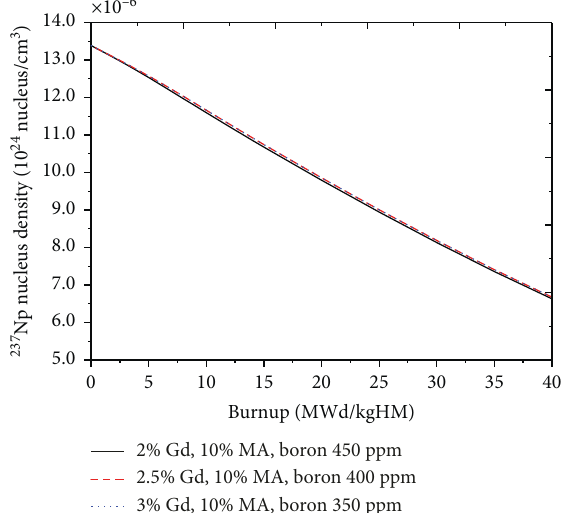
Figure 13: Transmutation of 237 Np versus burnup when loading 10wt.% of MAs.